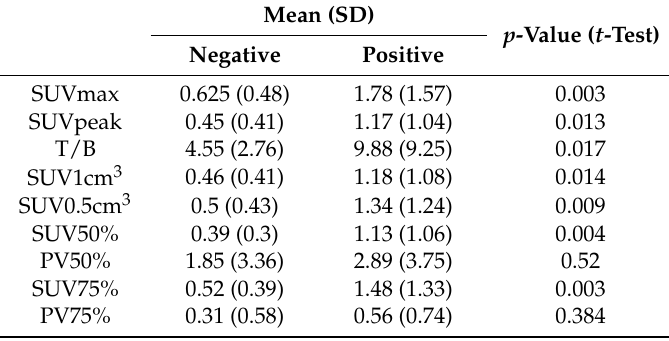
Table 2. Mean (standard deviation) of different parameters for positive and negative lesions. Comparisons were made with independent t -test. p < 0.05 is considered statistically